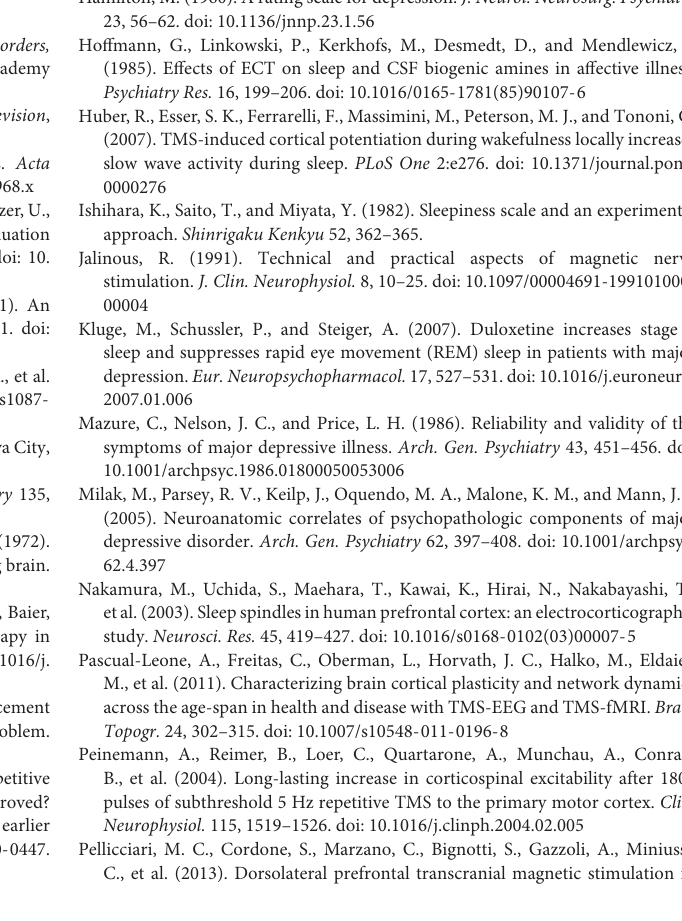
Supplementary Figure 1 | Spindle morphology and sigma power changes at F3 over time. (A) Spindle duration changes from Baseline to Post-2. (B) Spindle amplitude changes from Baseline to Post-2. There was a trend-level decrease ( P = 0.085) between Baseline and Post-1. (C) Sigma power per each spindle changes from Baseline to Post-2. There was a trend-level decrease ( P = 0.084) between Baseline and Post-1. (D) Sigma power per minute changes from Baseline to